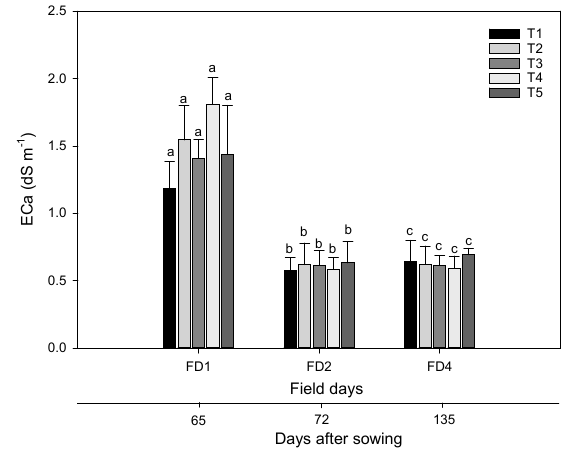
Figure 8. Effect of different soil amendments on temporal variations in apparent electrical conductivity at 0–10 cm sowing depth in podzolic soils under various nutrient management practices. Each vertical bar represents mean whereas bar errors show ±standard error for three replications. Lettering is independent of each other.